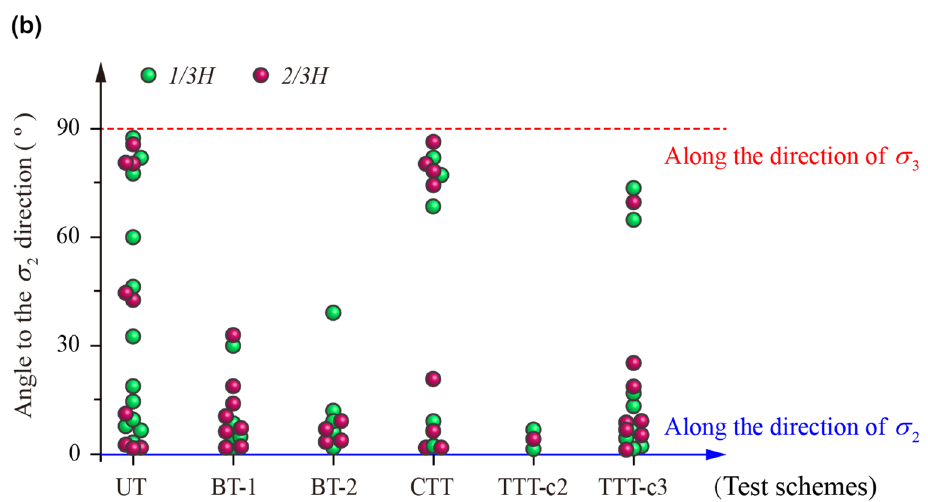
Figure 11. ( a ) Simplified linear cracking model example under CTT conditions; ( b ) distribution of angle between initiation crack and intermediate principal stress of the rock under different stress conditions.